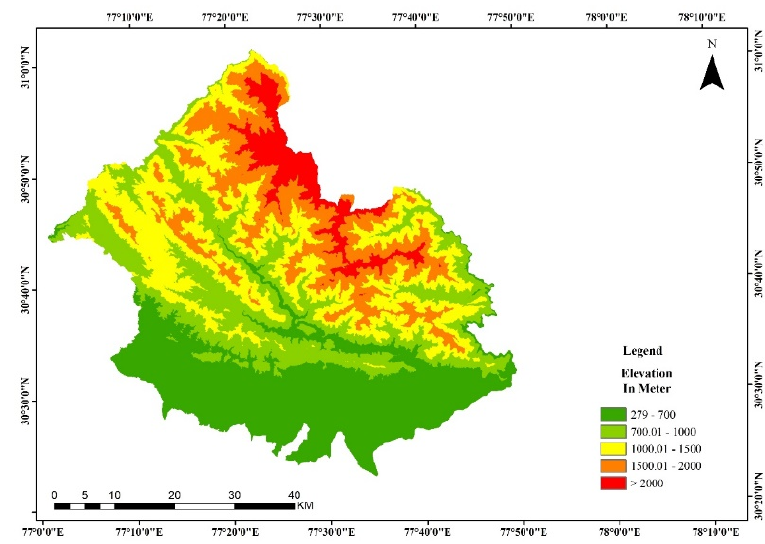
Figure 8. Elevation